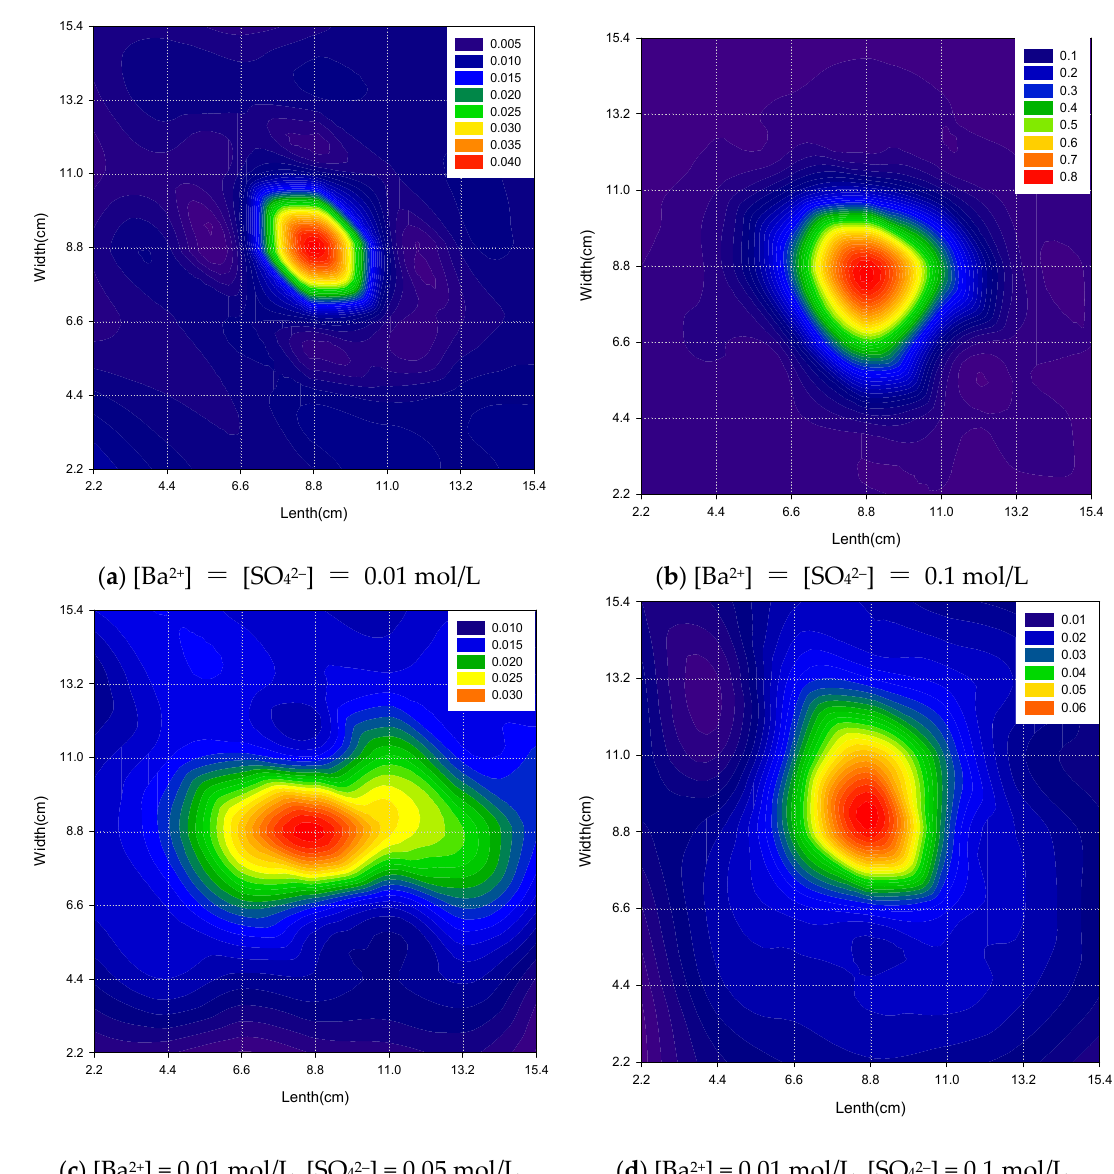
Figure 5. Ion precipitation contour distribution at different ion concentrations.